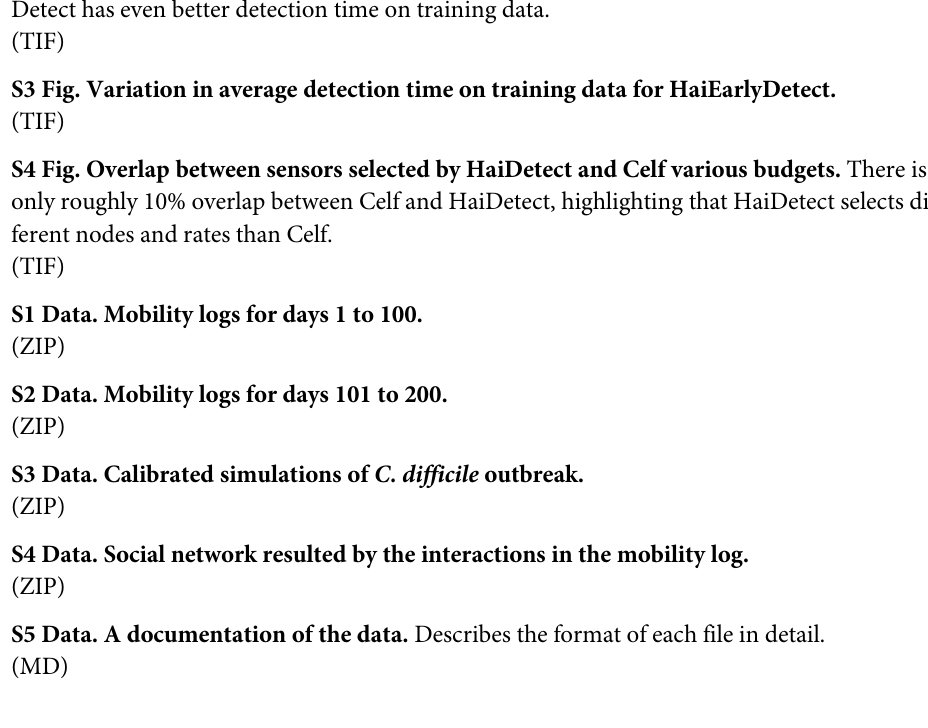
S2 Fig. Average detection time on training data for HaiEarlyDetect. As expected, HaiEarly- Detect has even better detection time on training data. S3 Fig. Variation in average detection time on training data for HaiEarlyDetect. S4 Fig. Overlap between sensors selected by HaiDetect and Celf various budgets. There is only roughly 10% overlap between Celf and HaiDetect, highlighting that HaiDetect selects dif- ferent nodes and rates than